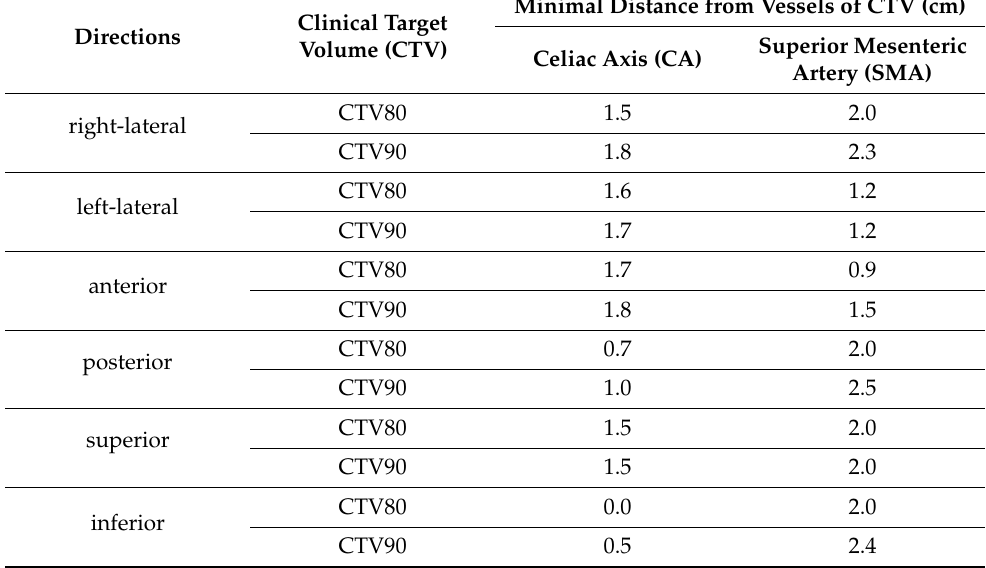
Table 3. Minimal distance from the celiac axis and the superior mesenteric artery of CTV80 and CTV90 extracted from the iso-level recurrence probability at 80% and 90%, respectively.